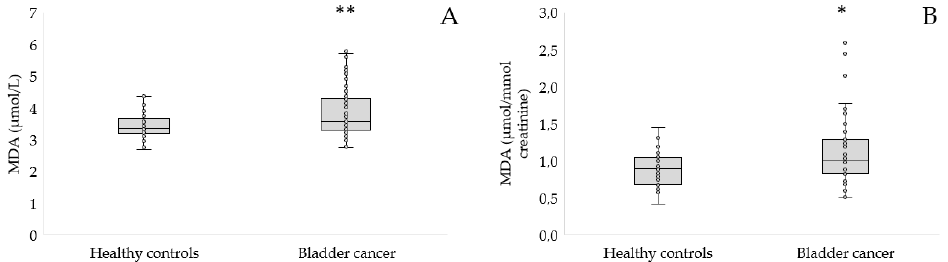
Figure 5. Concentration of MDA in serum ( A ) and urine ( B ) of patients with bladder cancer in comparison to the controls; * p < 0.05, ** p < 0.01.